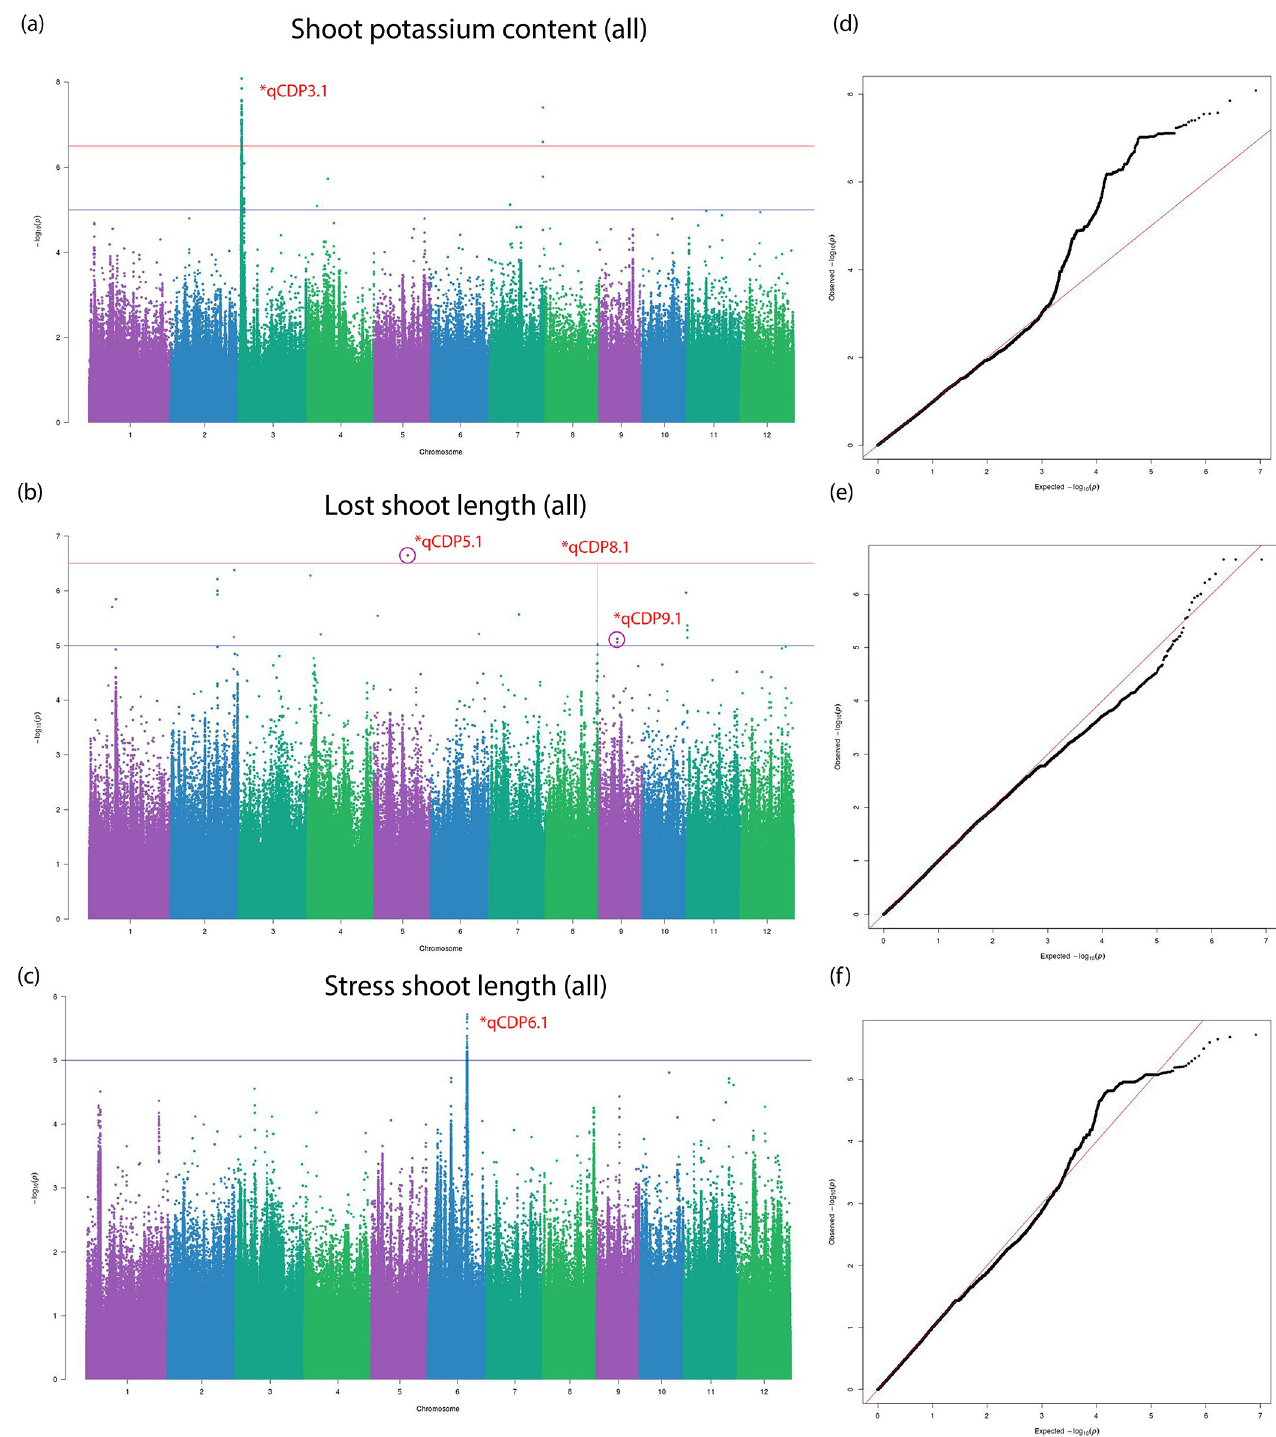
Fig 6. Manhattan and Q-Q plots for qCDP3.1, qCDP5.1, qCDP6.1, qCDP8.1 and qCDP9.1. Horizontal red and blue lines show the significant and suggestive thresholds respectively. Vertical black dotted lines show the locations of the five QTLs in the three Manhattan plots.